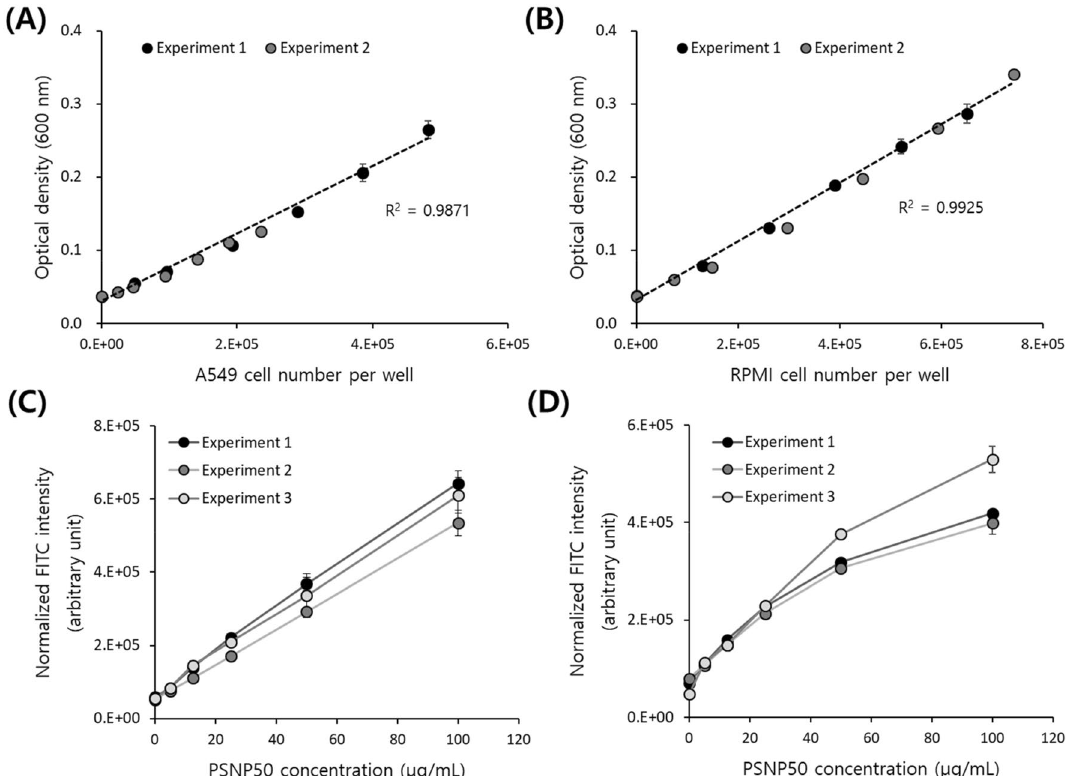
Figure 5. Scatter plots showing the correlation between cell number and optical density measured at 600 nm for ( A ) A549 and ( B ) RPMI8226 cells. FITC-PSNP50 uptake results of different sets of experiments with ( C ) A549 and ( D ) RPMI8226